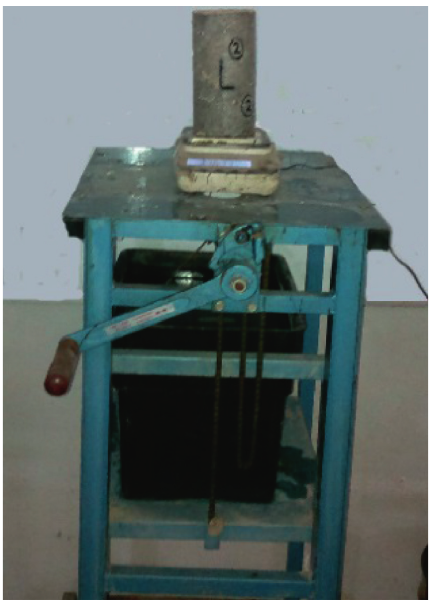
Figure 5: Apparatus of the density